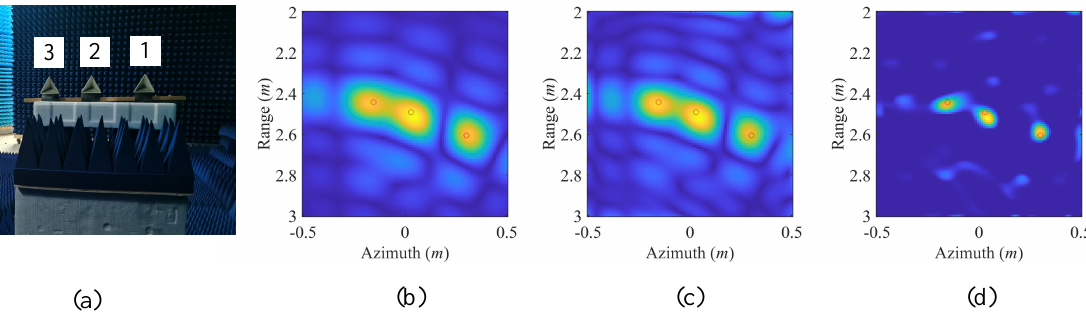
Figure 11. Imaging results of the real-world experiemnt of TD-MSCI. ( a ) is the photo of the three reflectors. ( b – d ) are recovery results from MF, Tikhonov regularization, TV regularization method,